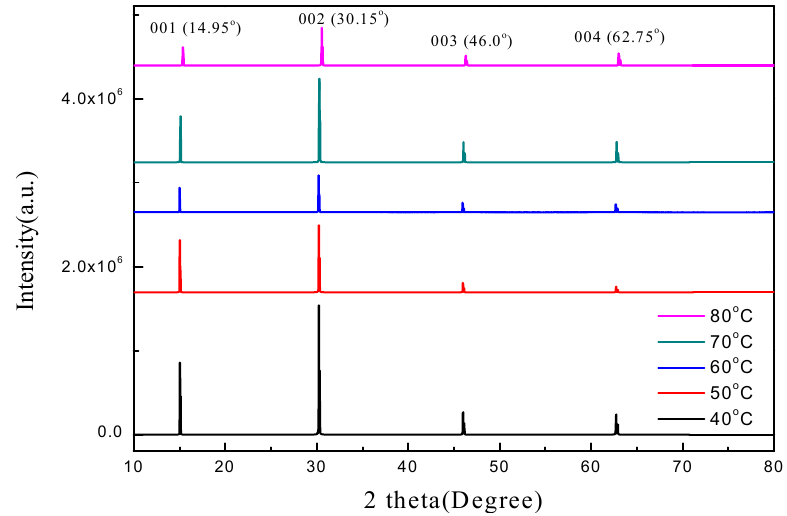
Figure 6. X-ray diffraction (XRD) patterns of the MAPbBr 3 crystals prepared at various temperatures.